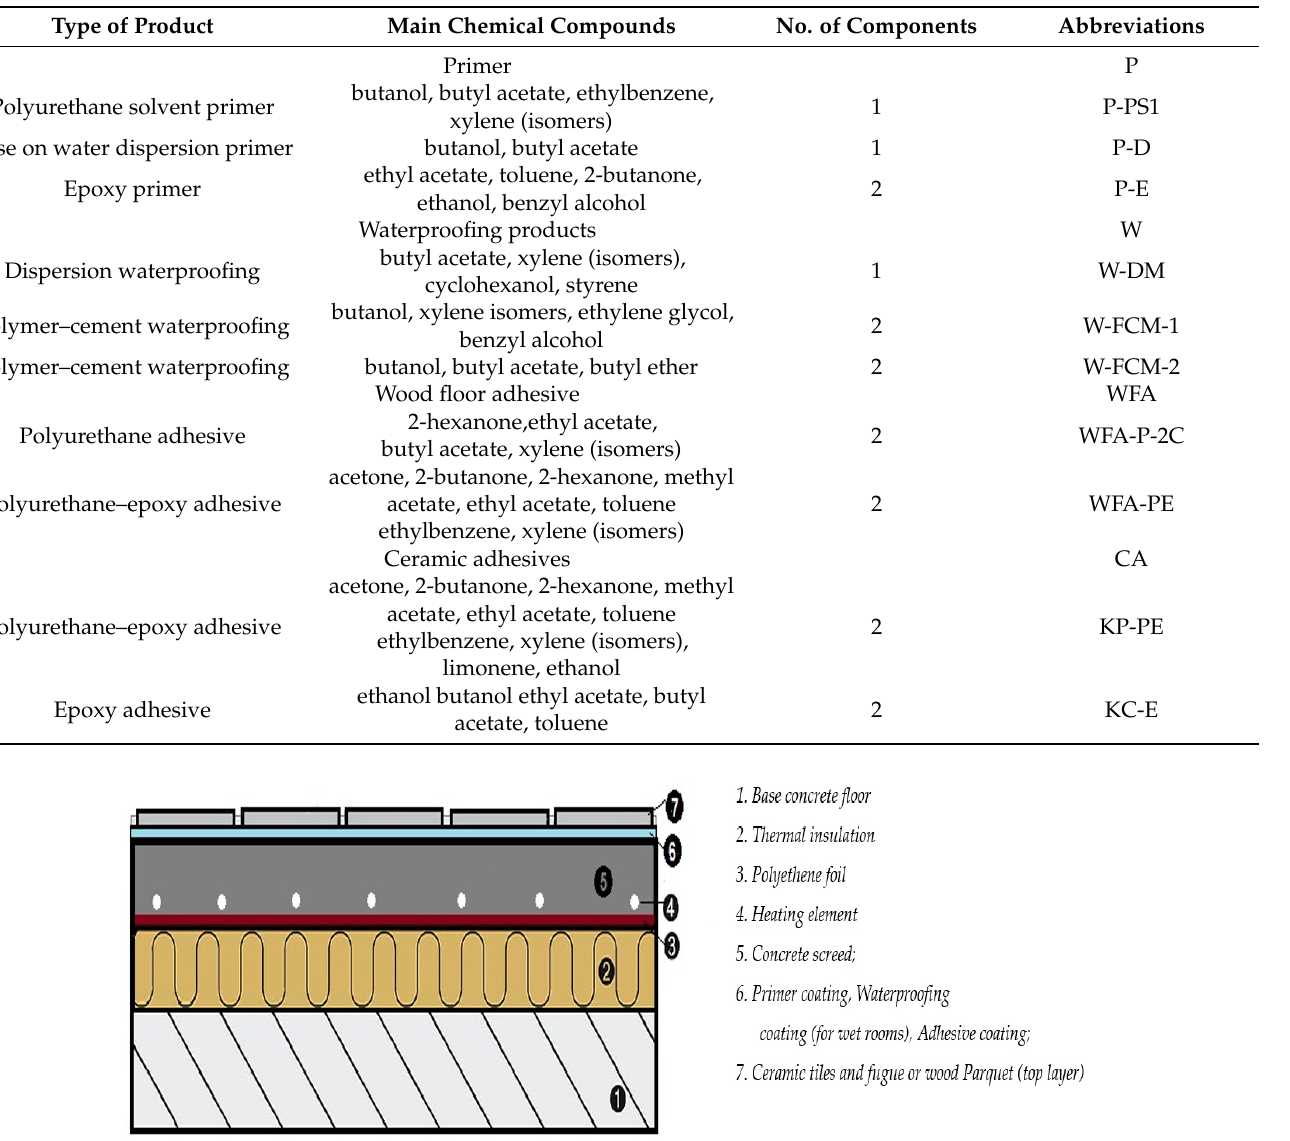
Table 1. Main chemical composition of products located under the top of the heating floor.